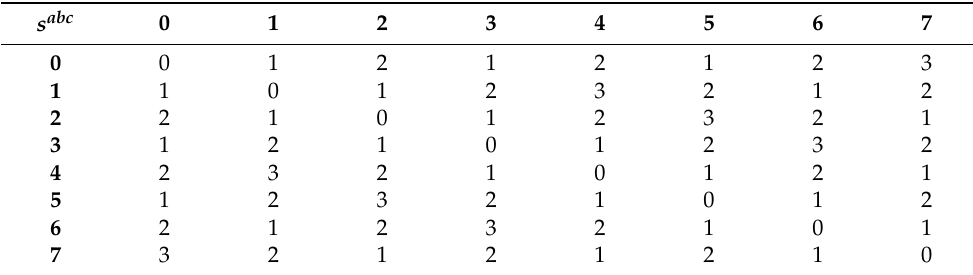
Table 2. The number of switches between two